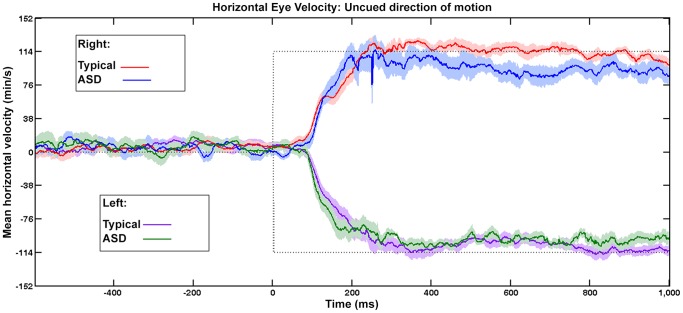
Mean Eye Velocity Over Time, Motion in Uncued Directions.Mean horizontal eye velocity (average of participant means) when no cue indicated the future path of the moving disc (left or right), for ASD (blue and green lines) and typical (red and purple lines) participants. The dotted line indicates the horizontal velocity of the disc. The disc entered the oblique branch at time  = 0 and traveled either to the right (positive values) or left (negative values) Shading indicates +/− Standard Error.